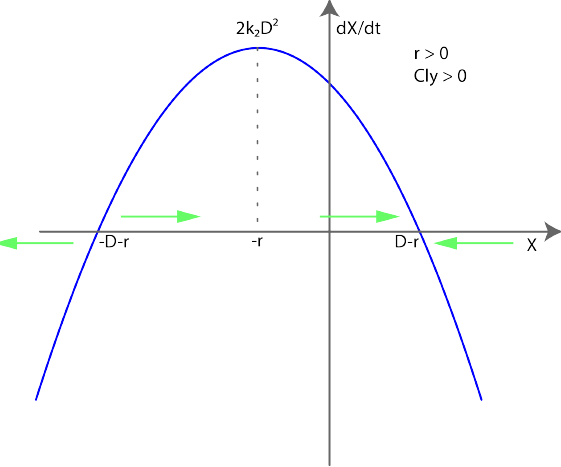
Figure D1. When k 1 > 0, or equivalently r > 0, there is a single stable limit point. X will converge to D − r as long as X > − D − r .